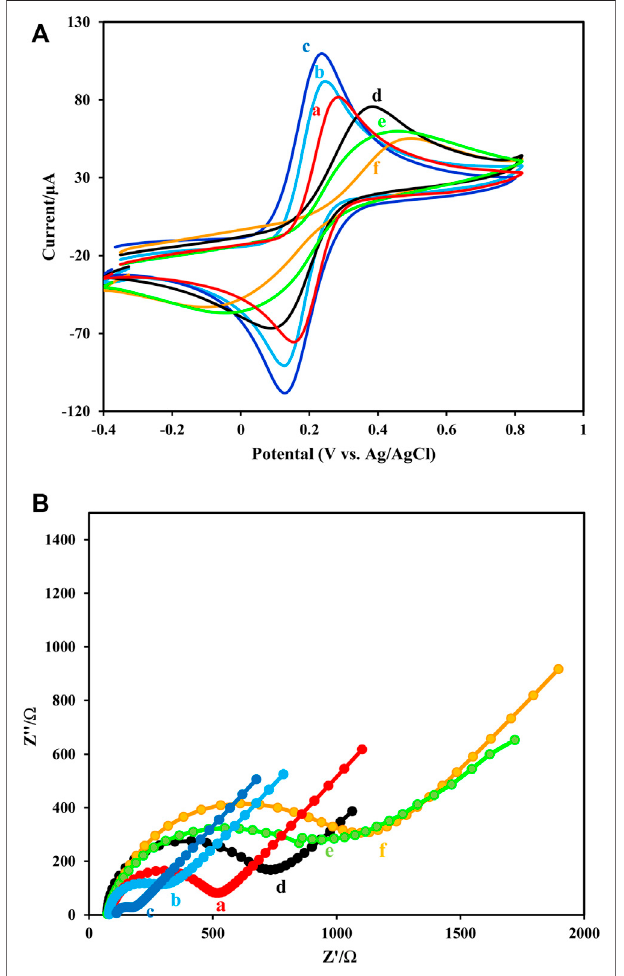
FIGURE 5 | (A,B) Cyclic voltammograms and (B) Nyquist diagrams of 5.0 mM [Fe(CN) 6 ] 3-/4- (0.1 M KCl) and scan rate of 50 mV s − 1 recorded at (a) GCE, (b) GCE/Fe 3 O 4 @ TMU-24, (c) GCE/Fe 3 O 4 @ TMU-24-AuNPs, (d) GCE/ Fe